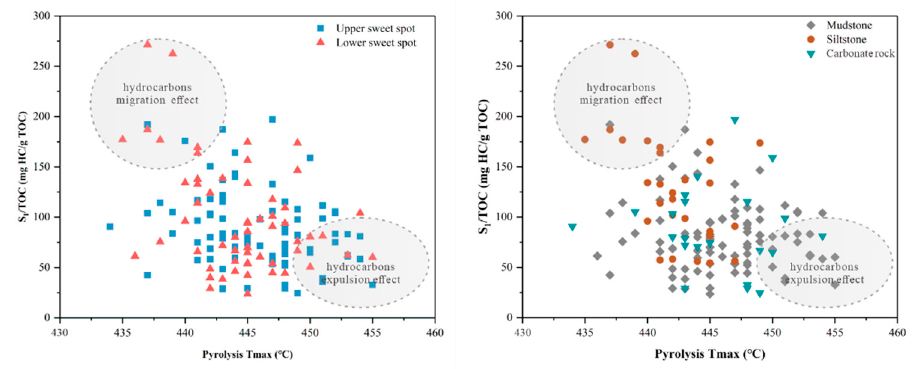
Figure 3. Plot of S 1 / TOC vs. Tmax to evaluate the oil-bearing level and the e ff ect of hydrocarbon expulsion or migration.